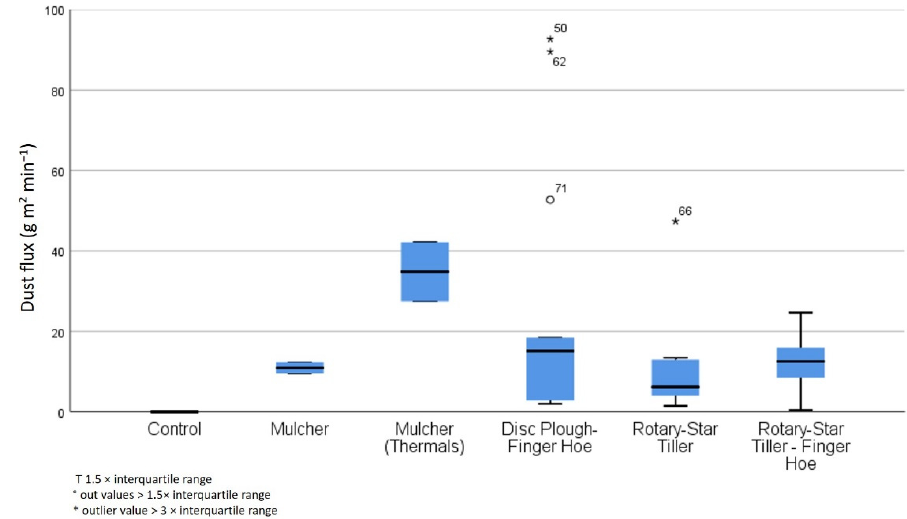
Figure 6. Collected dust on tillage device for all tested cultivation operations and control. Table 2. Mean dust flux for cultivation operations.